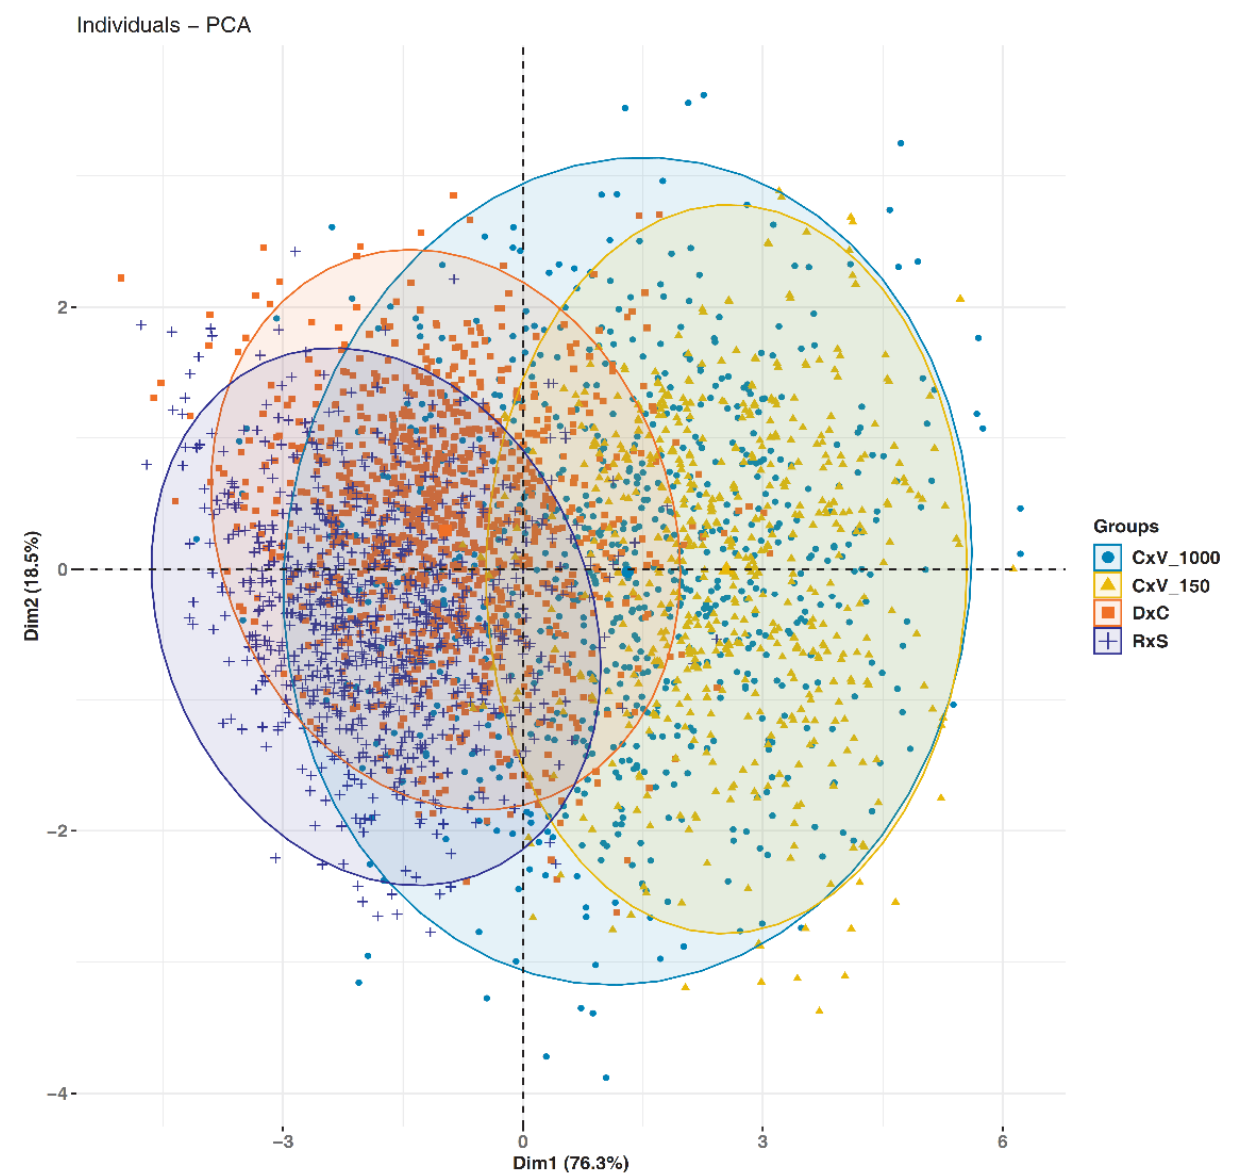
Figure 2. Principal component analysis for phenotypic values of different populations. Score plot shows results of phenotypic values from all individuals of the populations C × V_1000 (blue), C × V_150 (yellow), D × C (red), and R × S (cyan). Dim1 represents the first principal component (PCA), explaining 76.3%, and Dim2, represents PCA2, explaining 18.5% of the variation in the data. Traits for PCA1 are TV, W, L, and BN; PCA2 traits are BV, Dia, and